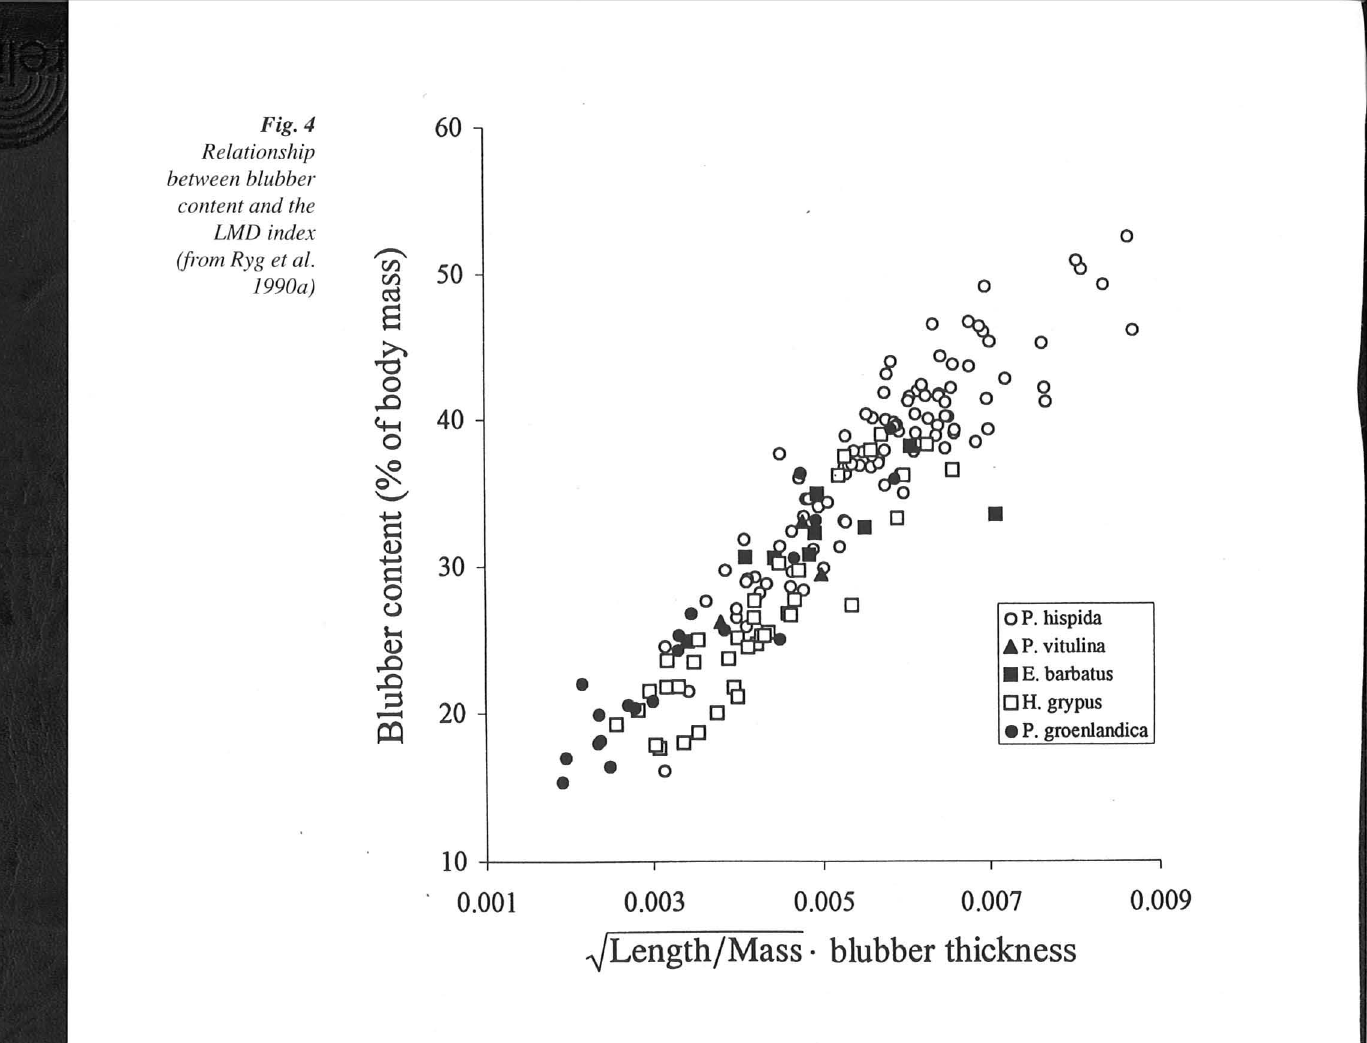
Fig. 4 Relationship between blubber content and the LMD index (from Ryg et